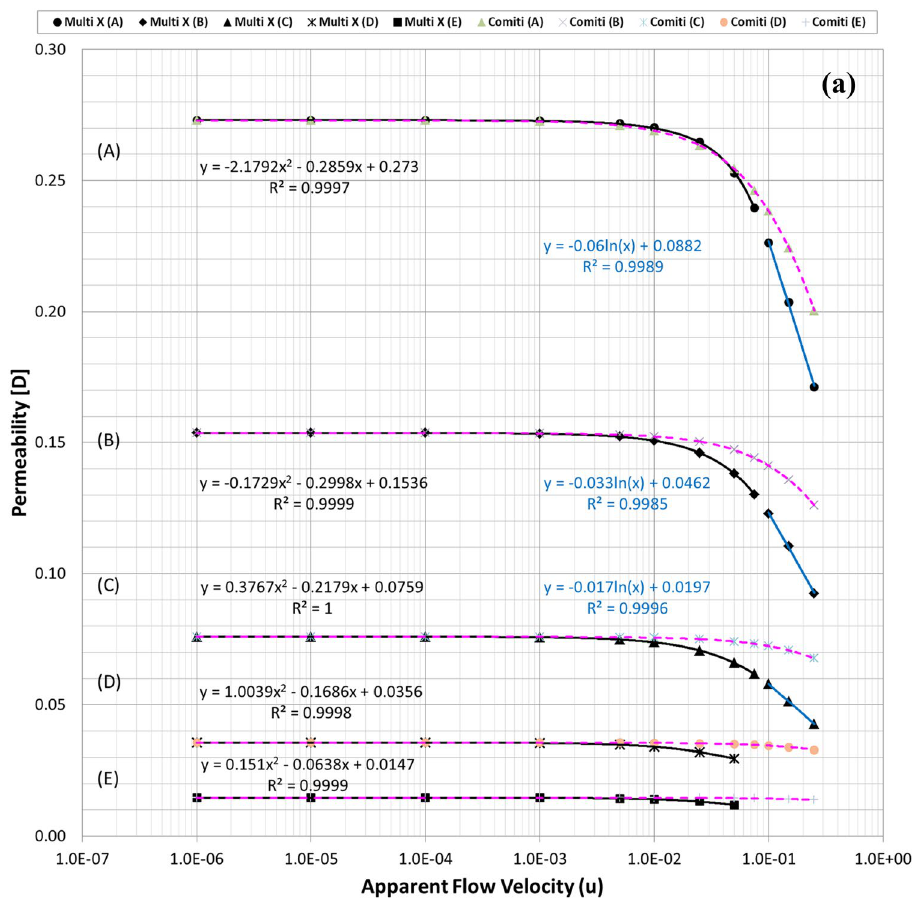
Figure 5. (a) Comparisons of the permeability variations of the multi-size pack models in the X-directional flow conditions using Eq. (4b) (dotted pink lines) and those directly obtained from each PSS analysis (solid black and blue lines). (b) Comparisons of the permeability variations of the multi-size pack models in the Y-directional flow conditions using Eq. (4b) (dotted pink lines) and those directly obtained from each PSS analysis (solid black and blue